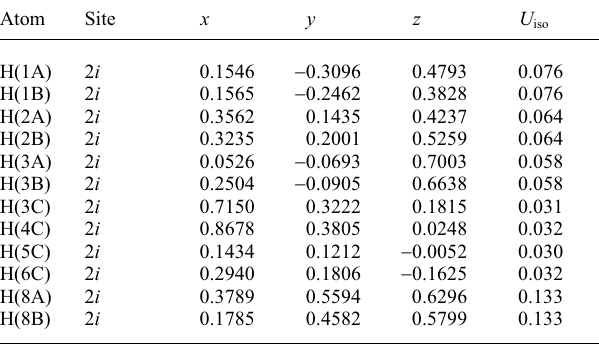
Table 2. Atomic coordinates and displacement parameters (in Å 2 )